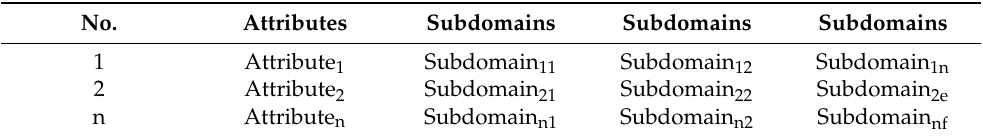
Table 3. Subdomain Label Table